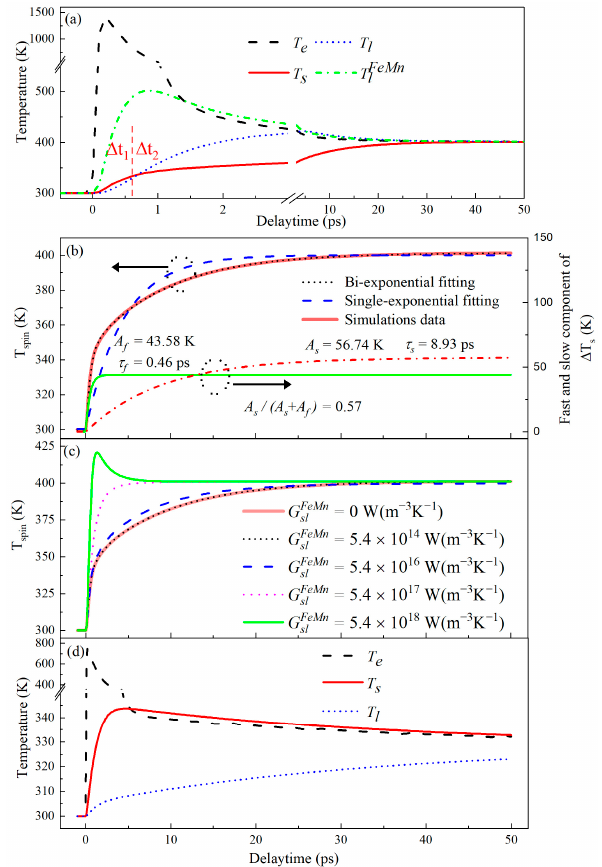
Figure 5. ( a ) Simulation temperature time evolution of electron (dash line), lattice of MnGa (dot line), lattice of FeMn (dot-dashed line), and spin (solid line) in an FeMn/MnGa layered structure at a pump fluence of 3.39 mJ/cm 2 in a 4T-M model. The time window is divided into two regions ∆ t 1 and ∆ t 2 for convenient discussions. ( b ) The temperature in the spin system alone (red solid line). The blue dash and black dot lines are fits of a single- and double-exponential sum function in Equation (1) functions, respectively. ( c ) Simulation time evolution of the spin temperature in an FeMn/MnGa layered structure at various phonon (FeMn)-spin coupling coefficient ( G FeMn ) values in a 4T-M model. sl ( d ) Simulations of the time evolution of electron (dash line), lattice (dot line) and spin (solid line) temperatures in a sole MnGa layer by 4T-M as all coupling channels between the FeMn and MnGa layers are turned